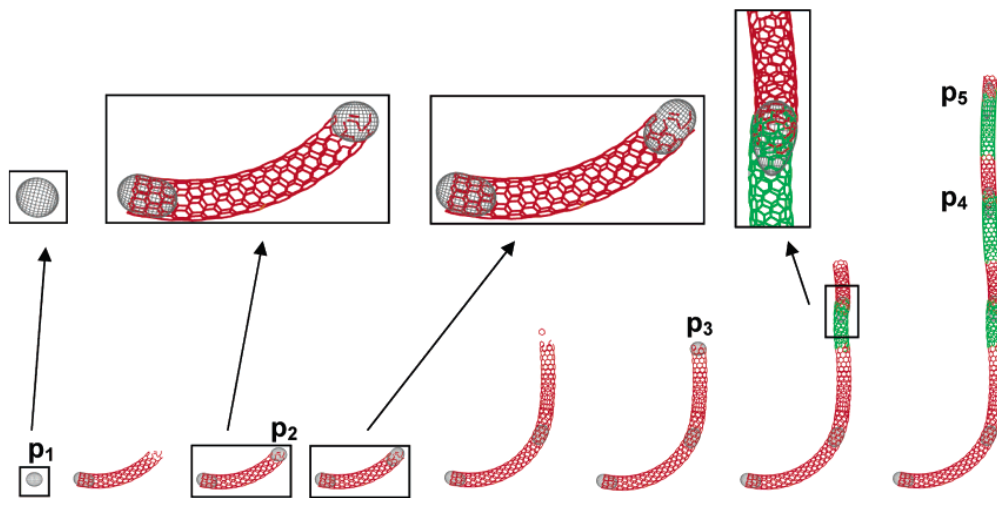
Figure 6. Representation of the model of concurrent base and tip growth modes for consecutive catalyst particles. (Dell’Acqua-Bellavitis, L.M.; Ballard, J.D.; Vajtai,